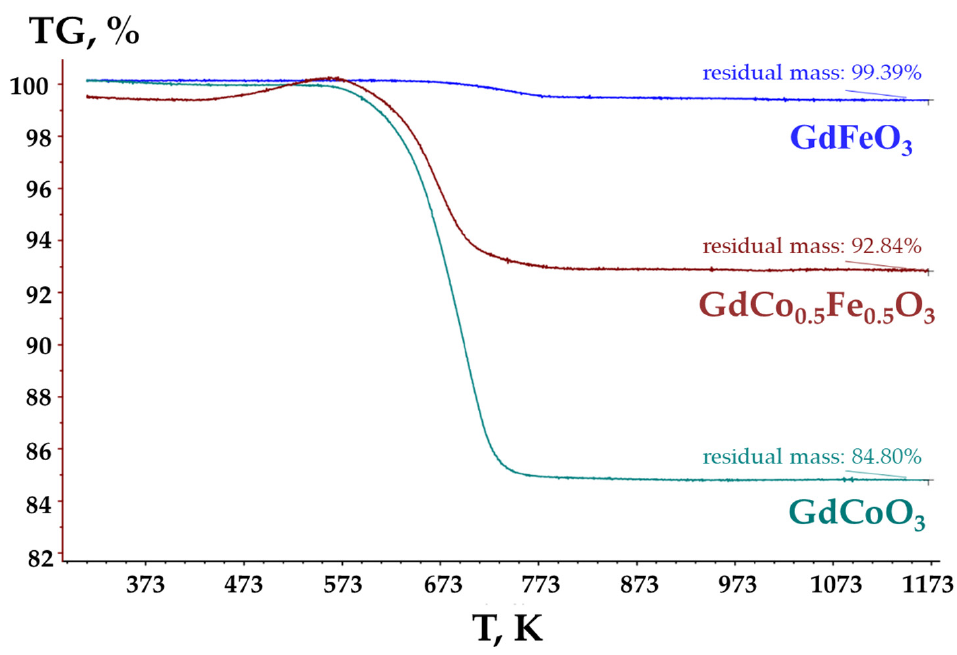
Figure 10. Mass loss curves for GdFeO 3 , GdCo 0.5 Fe 0.5 O 3 and GdCoO 3